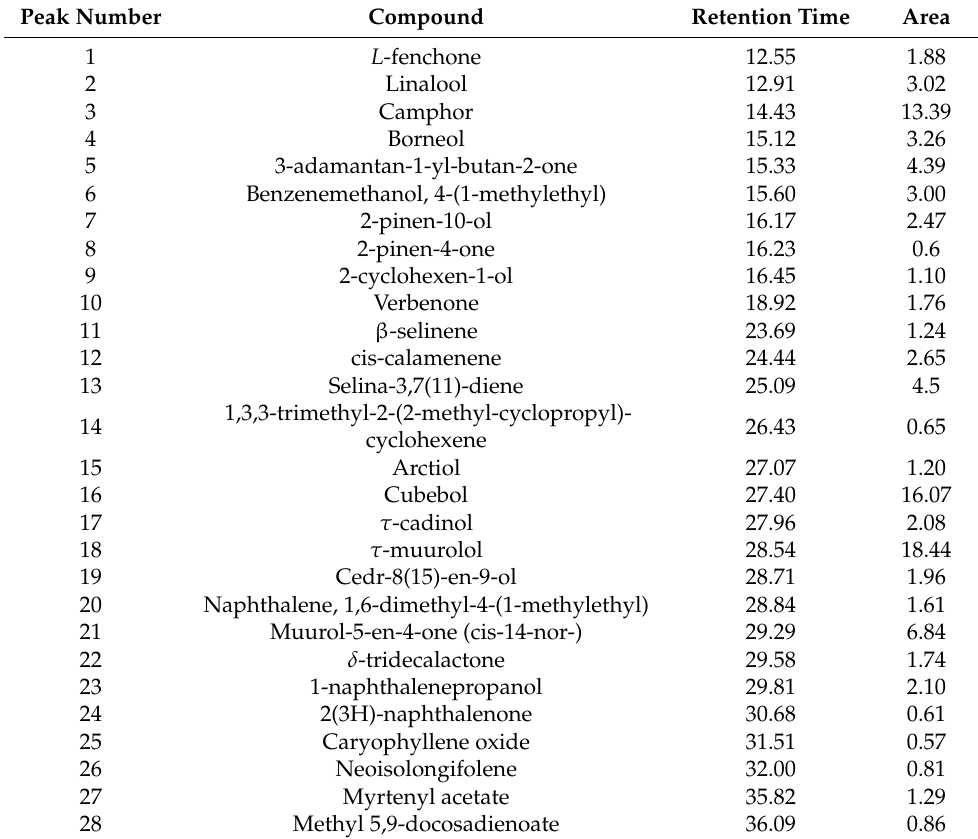
Table 3. Chemical composition of LSEO K . Peak Number Compound Retention Time